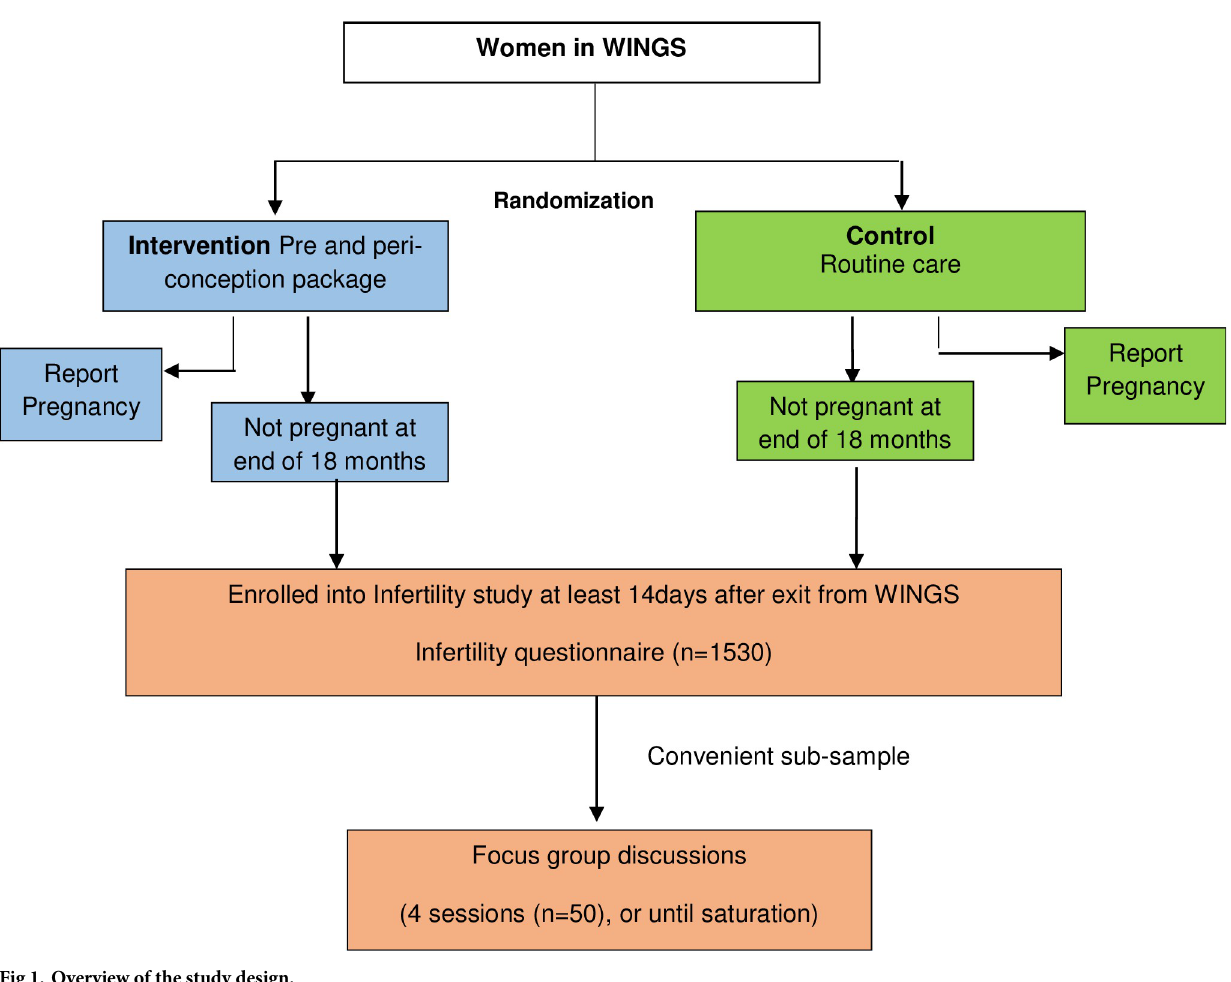
Fig 1. Overview of the study